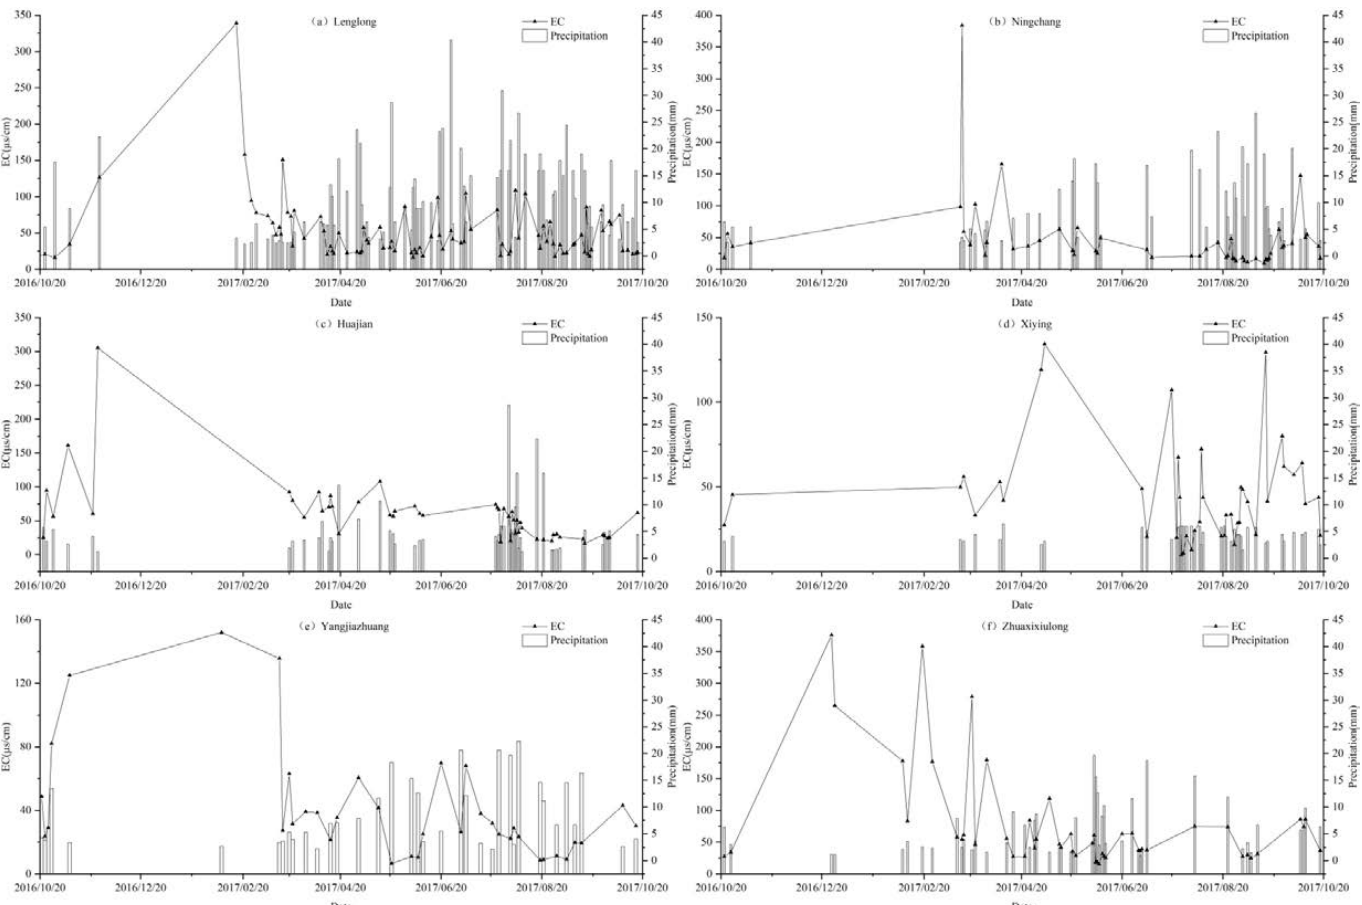
Figure 4. Seasonal variation in precipitation and electrical conductivity (EC).